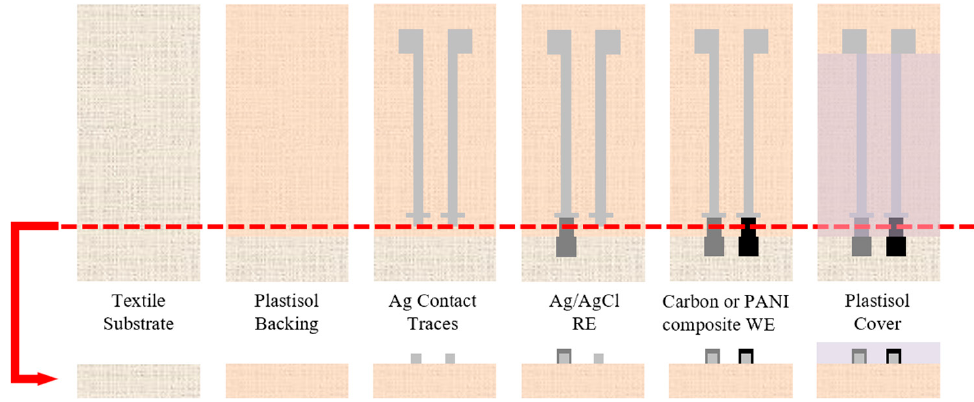
Figure 2. Fabrication process for textile-based SPEs showing top view ( top row ) and cross-sectional view ( bottom row ); all layers are screen-printed sequentially in order from left to right.